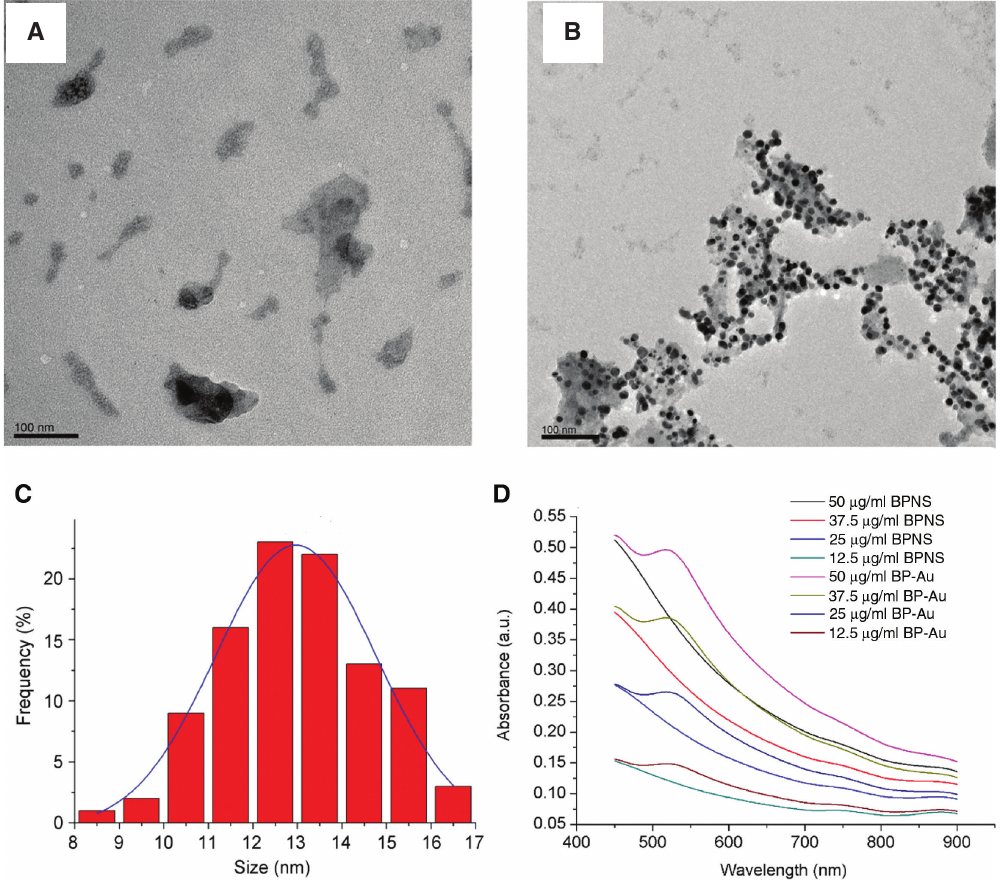
Figure 2: Characterization of the prepared black phosphorus nanosheets (BPNSs) and BP-Au nanocomposite. (A) The transmission electron microscopy (TEM) image of BPNSs. (B) TEM image of the BP-Au nanocomposite. (C) Particle size statistics of Au nanoparticles on the surface of the BP-Au nanocomposite. (D) Visible-near-infrared (Vis-NIR) spectra of BPNS and the BP-Au nanocomposite with the concentration ranging from 12.5 μ g/ml to 50 μ